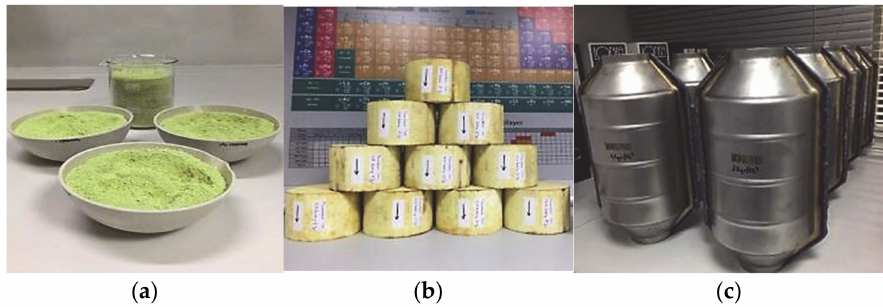
Figure 1. ( a ) Preparation of large-scale PROMETHEUS catalysts (1 kg); ( b ) PROMETHEUS